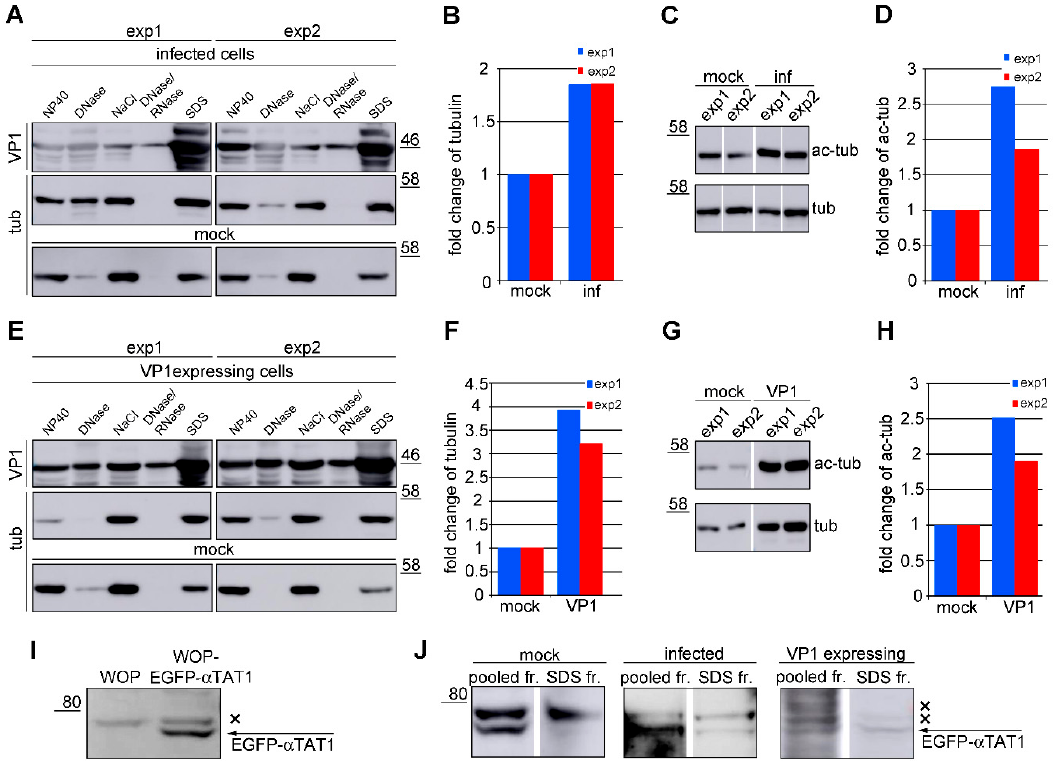
Figure 6. α TAT1 is a part of the VP1–hyperacetylated microtubule complex. ( A , E ) Infected 3T6 cells ( A ) or VP1 expressing cells ( E ) were in situ fractionated; then, an equal amount of washed out material from each fraction was separated via SDS / PAGE and transferred onto the membrane. The presence of VP1 and tubulin (tub) in each fraction was determined by specific antibodies. ( B , F ) A graphic illustration of the densitometry analysis of the digital images of Western blots from two independent experiments. Presented are the fold changes of tubulin in the SDS fraction of the infected ( B ) or VP1-expressing cells ( F ), which were compared with mock-infected or mock-transfected cells. ( C , G ) An equal amount of the SDS fraction from infected (inf) ( C ) or VP1-expressing cells (VP1) ( G ) was resolved on SDS / PAGE, immunoblotted to the membrane and tubulin, and acetylated α -tubulin (ac-tub) was stained by specific antibodies. ( D , H ) A graphic illustration of the densitometry analysis of the digital images of Western blots from two independent experiments. Presented are the fold changes of α -tubulin acetylation ratios in the SDS fraction of the infected ( D ) or VP1-expressing cells ( H ), which were compared with those of the mock-infected or mock-transfected cells. ( I ) Lysates of WOP and WOP-EGFP- α TAT1 were separated by SDS / PAGE, blotted onto the membrane, and EGFP was stained by a specific antibody. ( J ) Infected (inf) or VP1-expessing cells were in situ fractionated, and equal amounts of the pooled fractions and SDS fraction were separated by SDS / PAGE, transferred onto the membrane, and EGFP was stained by a specific antibody; × indicates non-specific antibody